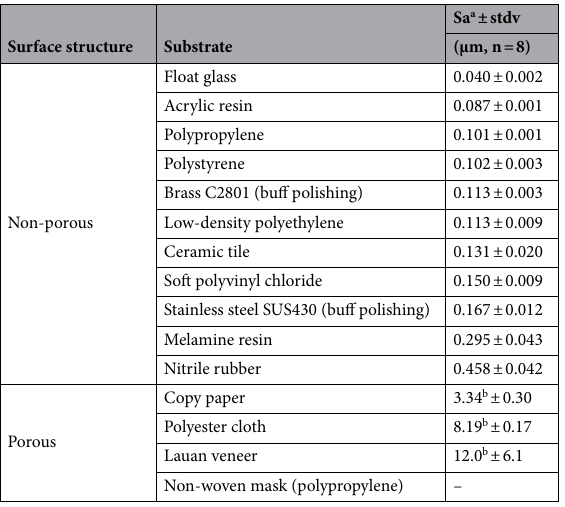
Table 1. Substrates and the area surface roughness (Sa). a × 20 magnification. b Reference